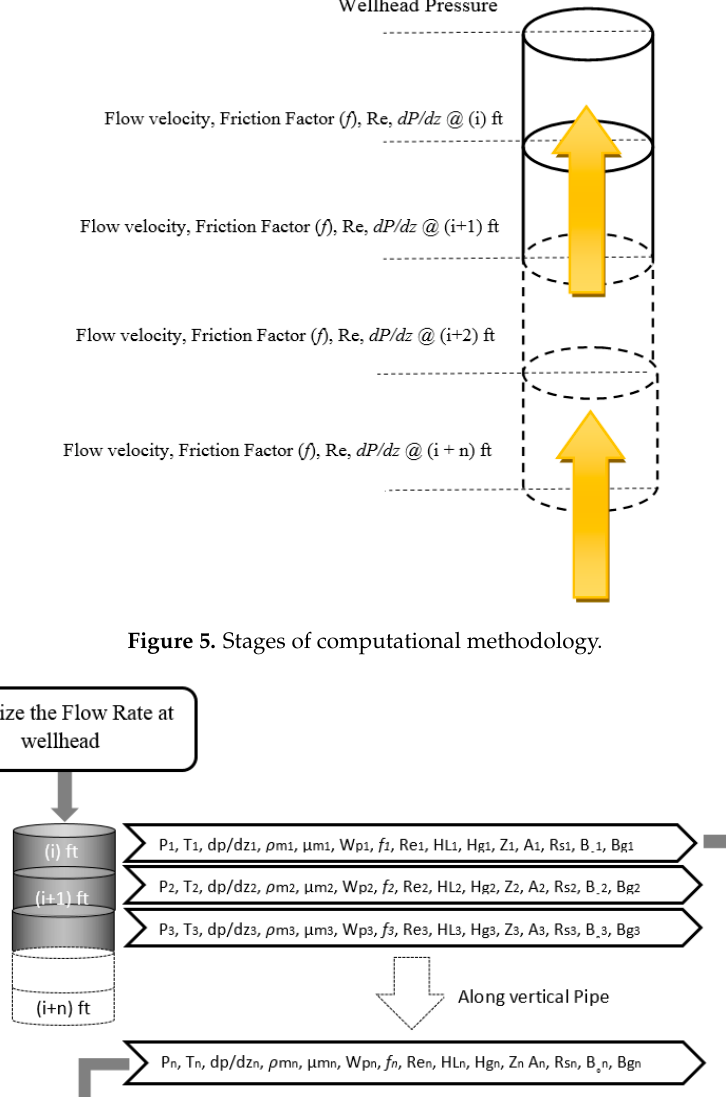
Figure 6. Flow diagram of new computational method procedure.